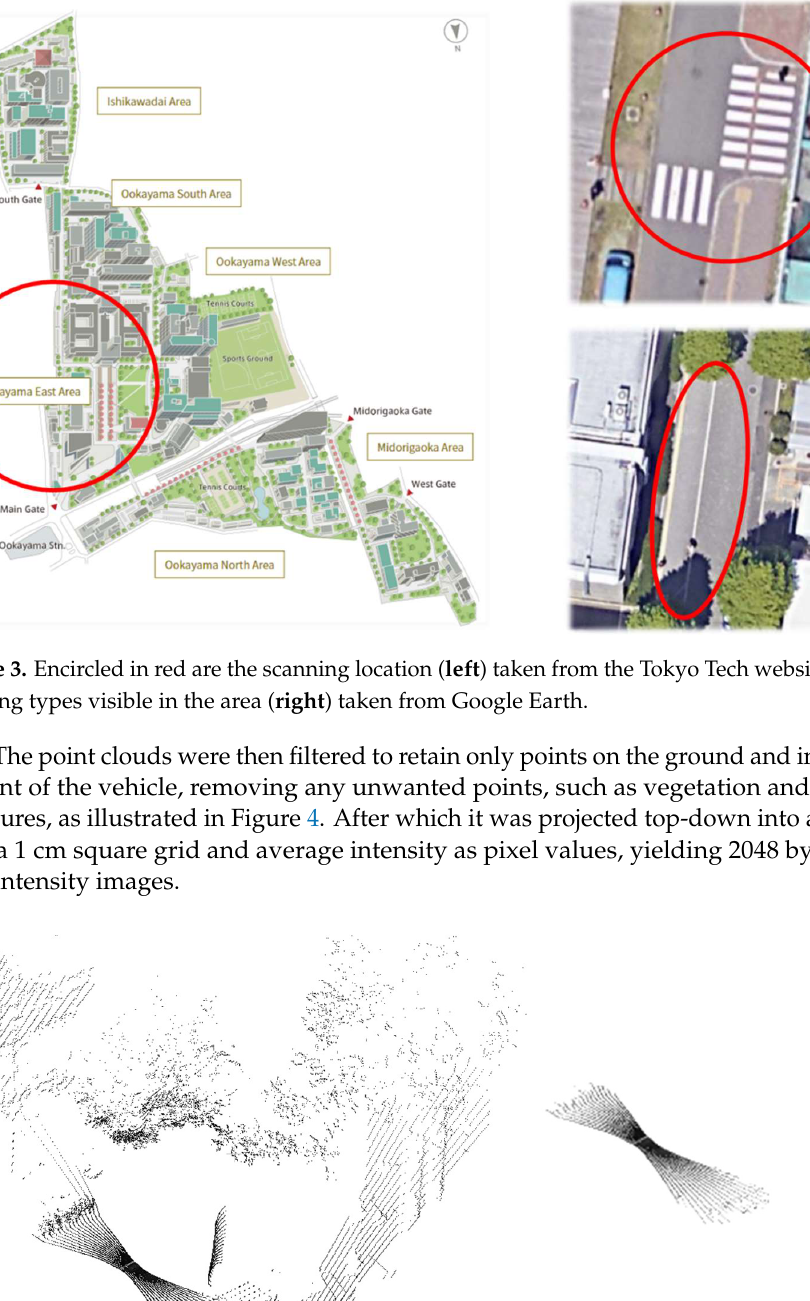
ment of road marking features but mainly consisted of lane lines and crosswalks. As a result, the target road markings were restricted to only these types.